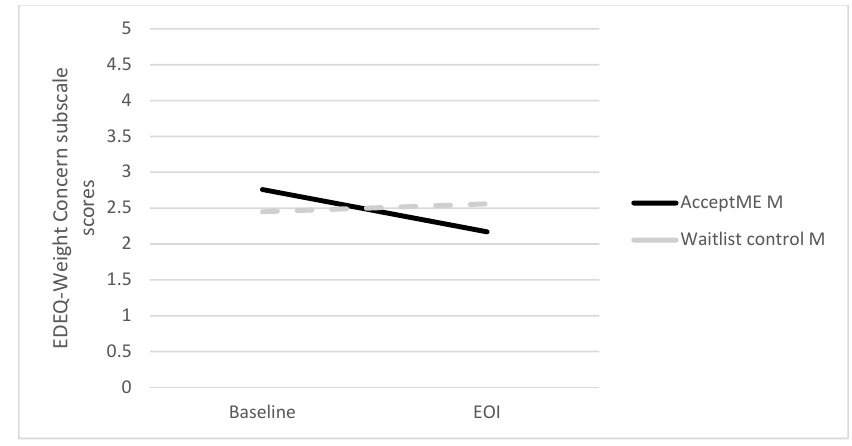
Figure 3. ( a ) Group by Time Interaction of EDEQ—Global score. ( b ) Group by Time Interaction of EDEQ—Shape concern subscale scores. ( c ) Group by Time Interaction of EDEQ—Weight concern subscale scores.